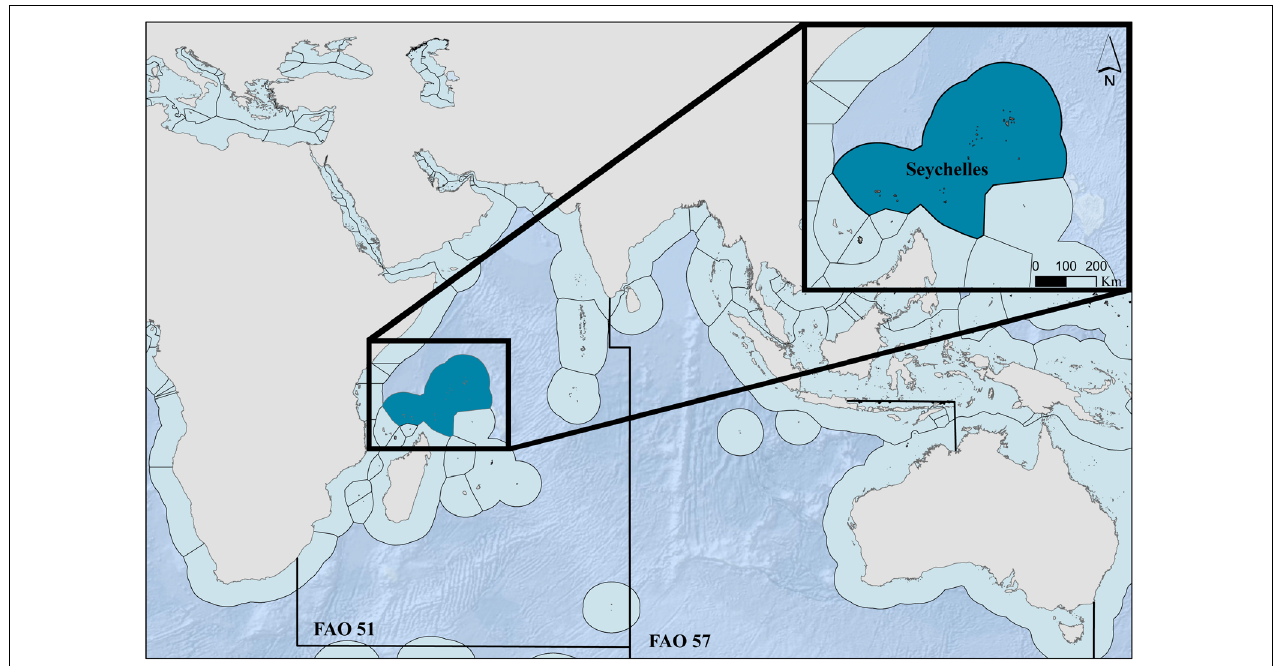
FIGURE 1 | The exclusive economic zone (EEZ) of the Republic of